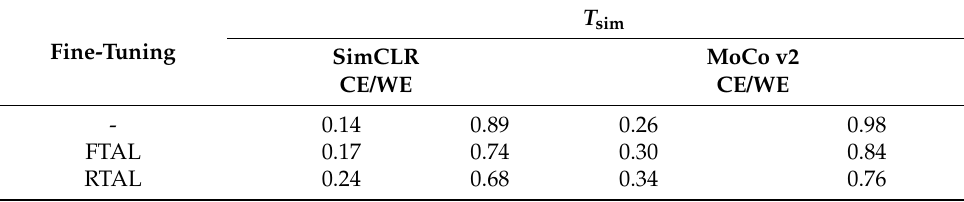
Table 6. Robustness against fine-tuning (under white-box condition).